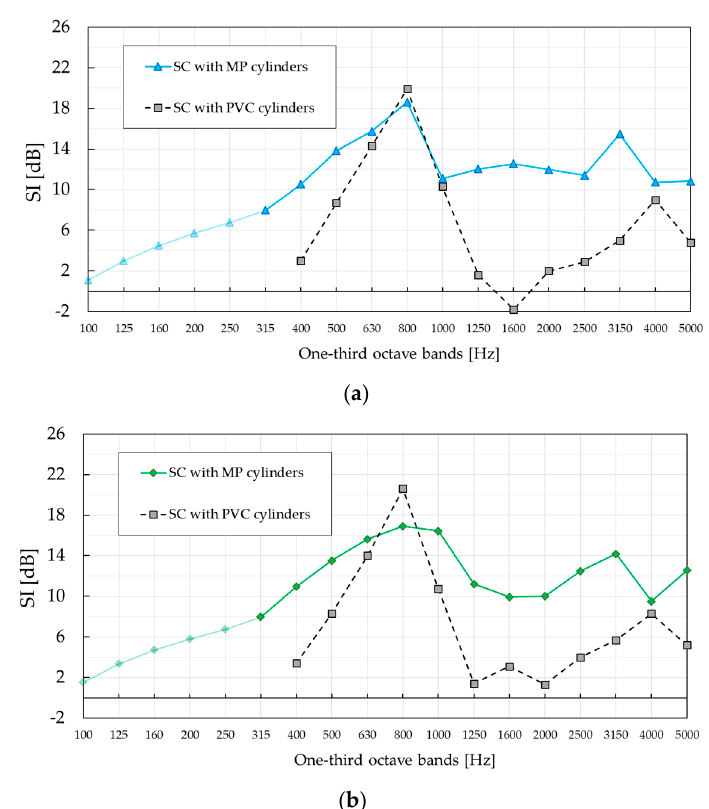
Figure 9. Sound insulation index sound insulation index ( SI) of SC barrier with micro-perforated (MP) cylinders measured in two different configurations. Results are compared with those of standardised characterisation of SC barrier with PVC cylinders presented in Figure 6 in [24]. ( a ) Sound insulation index SI , configuration A; ( b ) sound insulation index SI , configuration B .